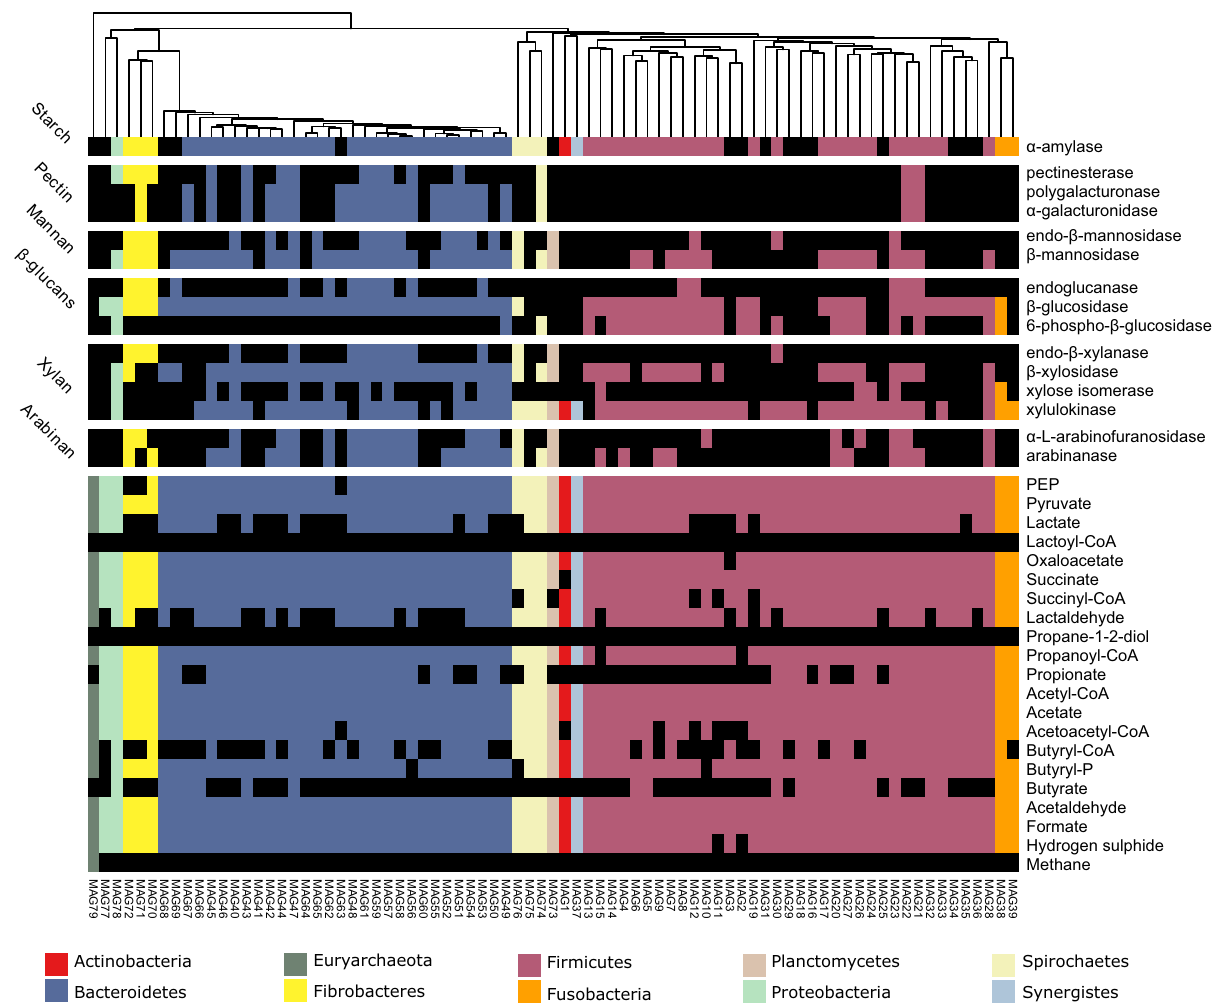
Fig. 5 Metabolic reconstruction of 79 unique metagenome-assembled genomes (MAGs) recovered from the capybara gut microbiome. Heatmap indicates the presence or absence of enzymes related to plant polysaccharides degradation or metabolites production (listed on the right) in each MAG (bottom) according to their set of genes. The presence of each enzyme/metabolite is denoted by a box colored based on the phylum taxonomic assignment, and black squares indicate the absence of the referred metabolite/enzyme. Heatmap is clustered according to the phylogeny of the recovered MAGs. To perform the metabolic reconstruction of each MAG, the annotation obtained from KOFAM database were fi ltered to keep only the top 5 hits of each protein ( e -value < 1e − 5). These fi ltered annotations were supplied to the Annotation of Metabolite Origins (AMON) tool, which predicts the metabolites that each MAG can produce, according to KEGG Orthologous